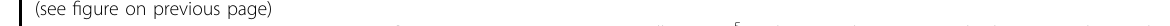
Fig. 6 IL-26 promotes in vivo tumor growth against EGFR-TKI. A E0771 cells (5 × 10 5 ) with Matrigel were injected subcutaneously into the fl ank of hIL-26Tg (IL-26Tg) or littermate control mice (WT) (each, n = 8). Ge fi tinib was administered by oral gavage (50 mg/kg) once a day fi ve times a week for the duration of the study from 10 days after E0771 cell inoculation. n = 8 mice for each group at each time point. mean ± SEM of each group. * p < 0.01. B Macroscopic manifestation of the tumors in experiment A. Tumors were resected at 30 days after inoculation. C E0771 cells (5 × 10 5 ) with Matrigel were inoculated subcutaneously into the fl ank of hIL-26Tg mice, and ge fi tinib was administered by the same method as described in experiment A. IL-26 mAb (clone 69-10) or mouse IgG isotype control (each, 200 µg/dose) was subsequently injected intraperitoneally once a day twice a week from 10 days after E0771 inoculation. n = 8 mice for each group at each time point. mean ± SEM of each group. * p < 0.01. D Macroscopic manifestation of the tumors in the experiment C. Tumors were resected at 30 days after inoculation. E E0771 cells (5 × 10 5 ) with Matrigel were inoculated subcutaneously into the fl ank of hIL-26Tg or control mice, and ge fi tinib was administered by the same method as described in experiment A. Anti-mouse EphA3 pAb or goat IgG isotype control (each, 100 µg/dose) was subsequently injected intraperitoneally once a day twice a week from 10 days after E0771 inoculation. n = 8 mice for each group at each time point. mean ± SEM of each group. * p < 0.01. F Macroscopic manifestation of the tumors in the experiment E. Tumors were resected at 30 days after inoculation. G Immuno fl uorescence staining of tumor specimens resected at 17 days after E0771 inoculation. Representative images are shown in Supplementary Fig. S13. Data are shown as mean ± S.E. of relative fl uorescence intensity from 8 mice for each group, comparing values in vehicle-treated WT mice, ge fi tinib-treated WT mice, or hIL-26Tg mice to those in vehicle-treated WT mice (* p < 0.01).